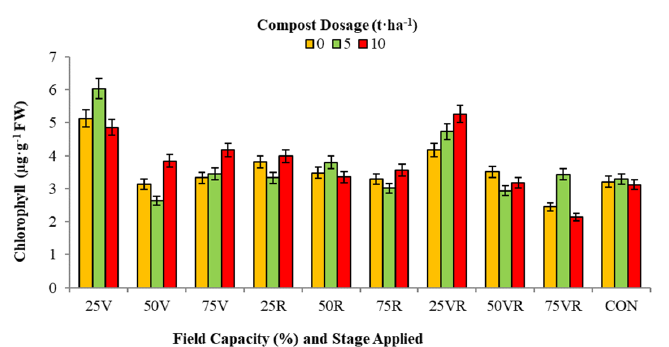
Figure 13. Effect of interaction of water regime, treatment stage and compost dosage on chlorophyll content of okra leaf at 5 weeks The 25, 50 and 75% represent field capacity; V (vegetative), R (reproductive), and VR (vegetative and reproductive) represent the stage at which the deficit was applied. Data in the interaction analysed with Least Squares Means, and means separated with LSD.